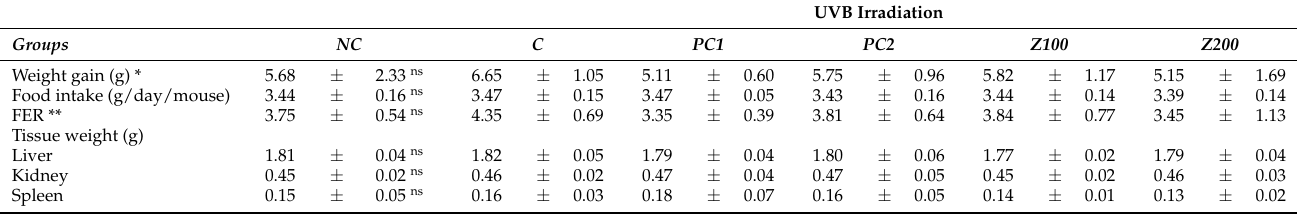
Table 2. Effects of FSH-ZM on body weight and organ weights of HRM-2 mice with or without UVB-irradiation.